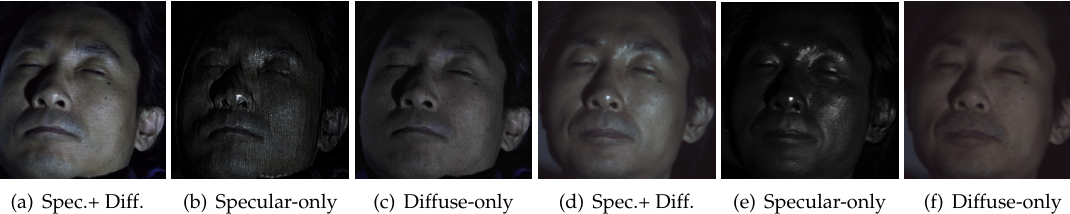
Figure 14. Comparison of specular and diffuse separation with the multi-shot technique of Nayar et al. [11] ( a – c ) and single-shot TPLF imaging ( d – f ). The same Lytro Illum camera and light source, the EUG WXGA LCD projector, were used for